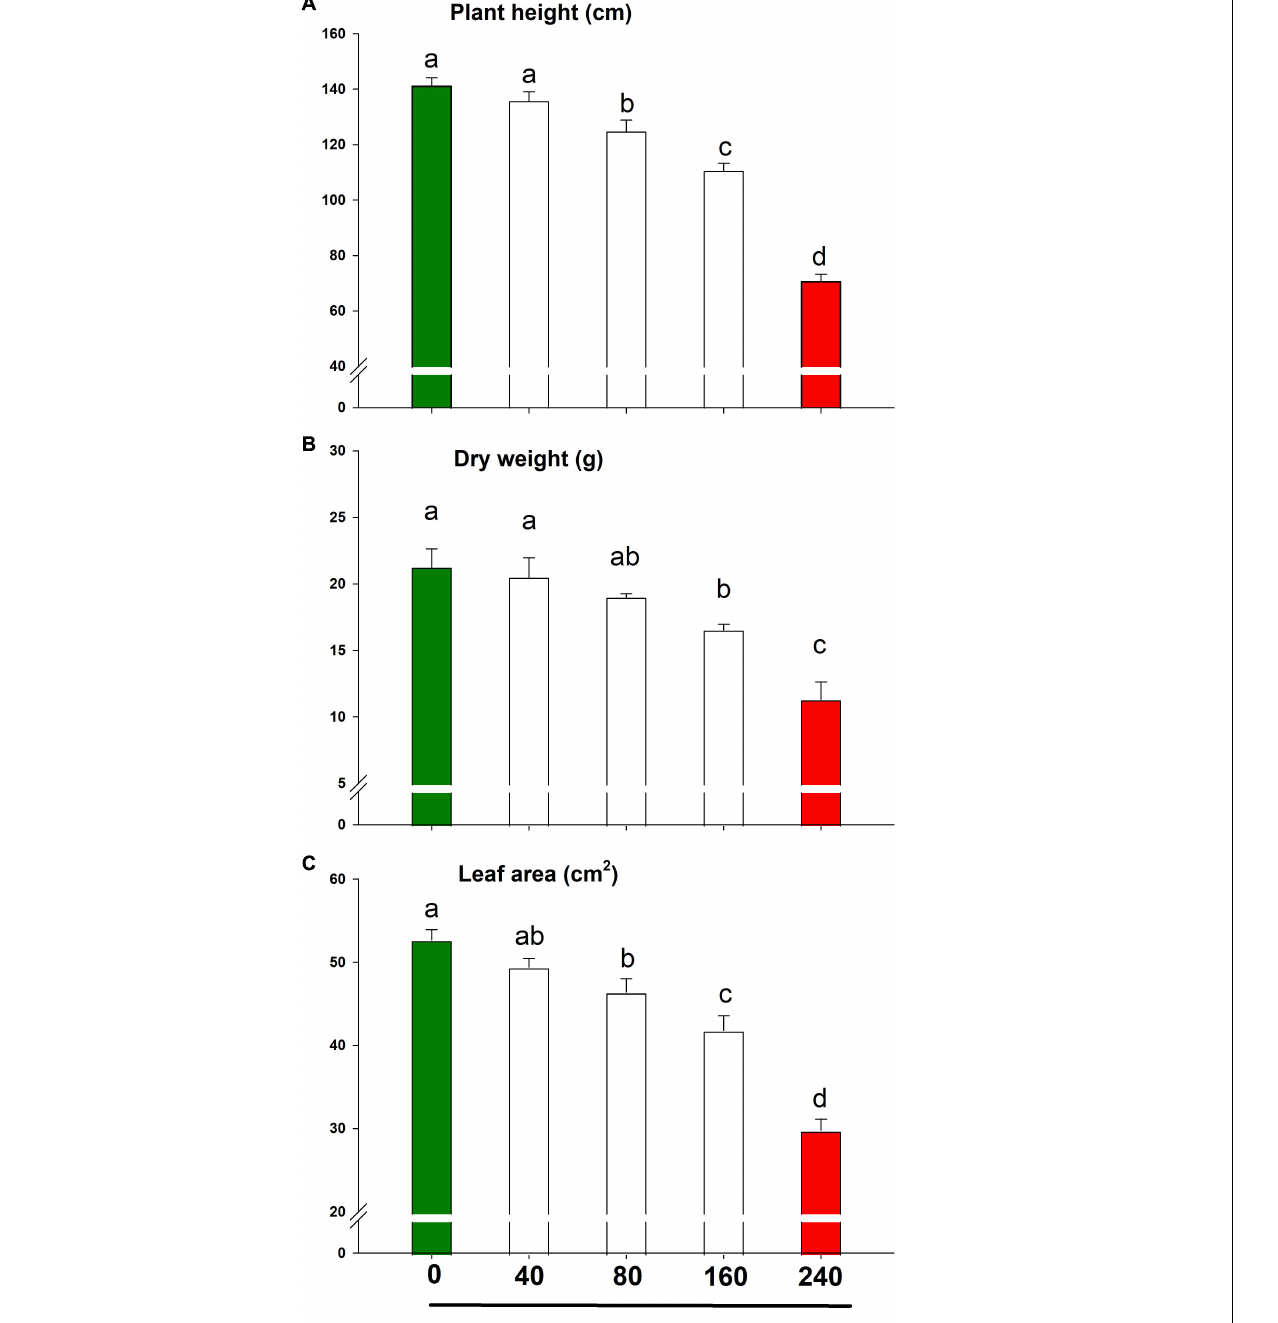
Frontiers in Plant Science |